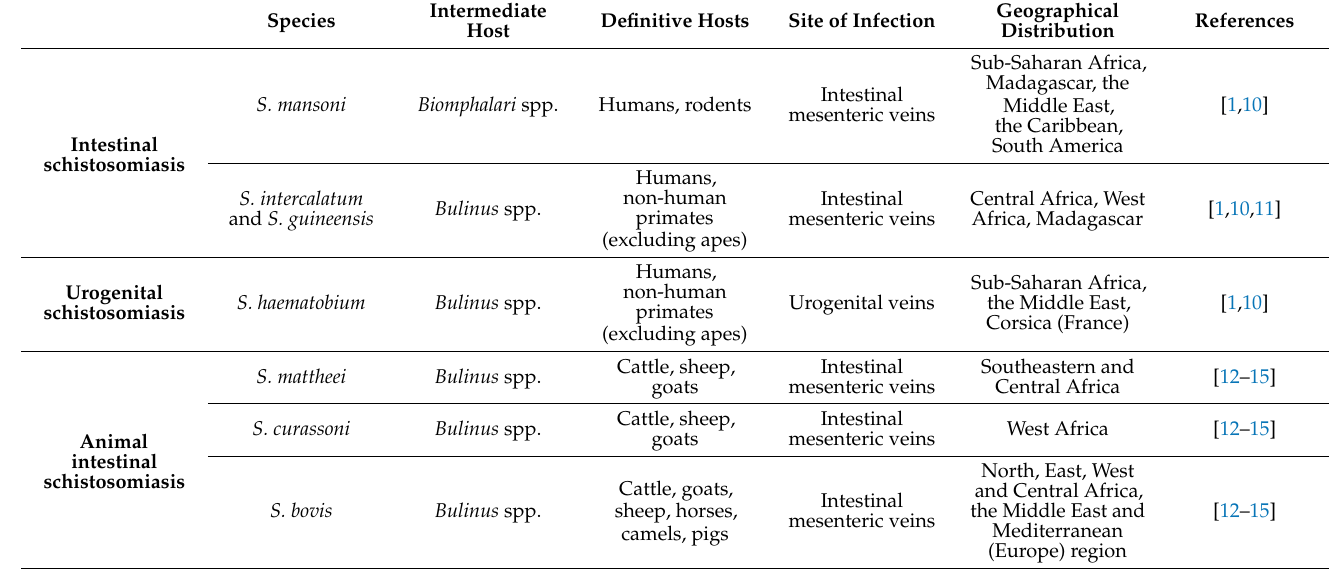
Table 1. African schistosome species and their geographical